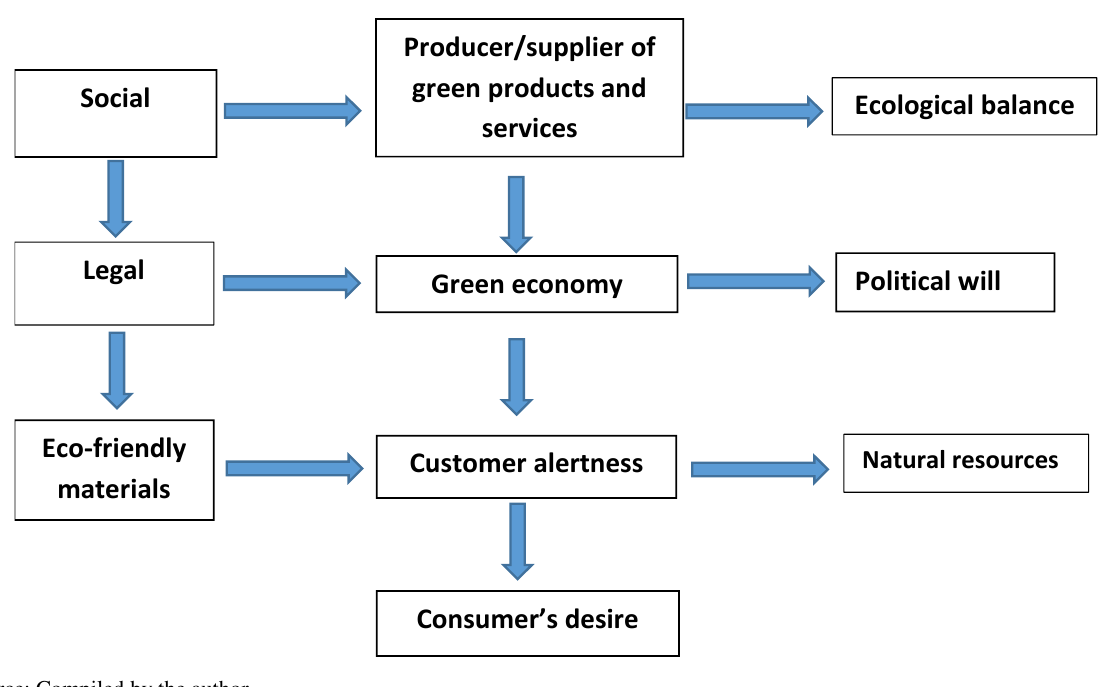
Fig. 2. Impact of green economy and environmental risk analysis and